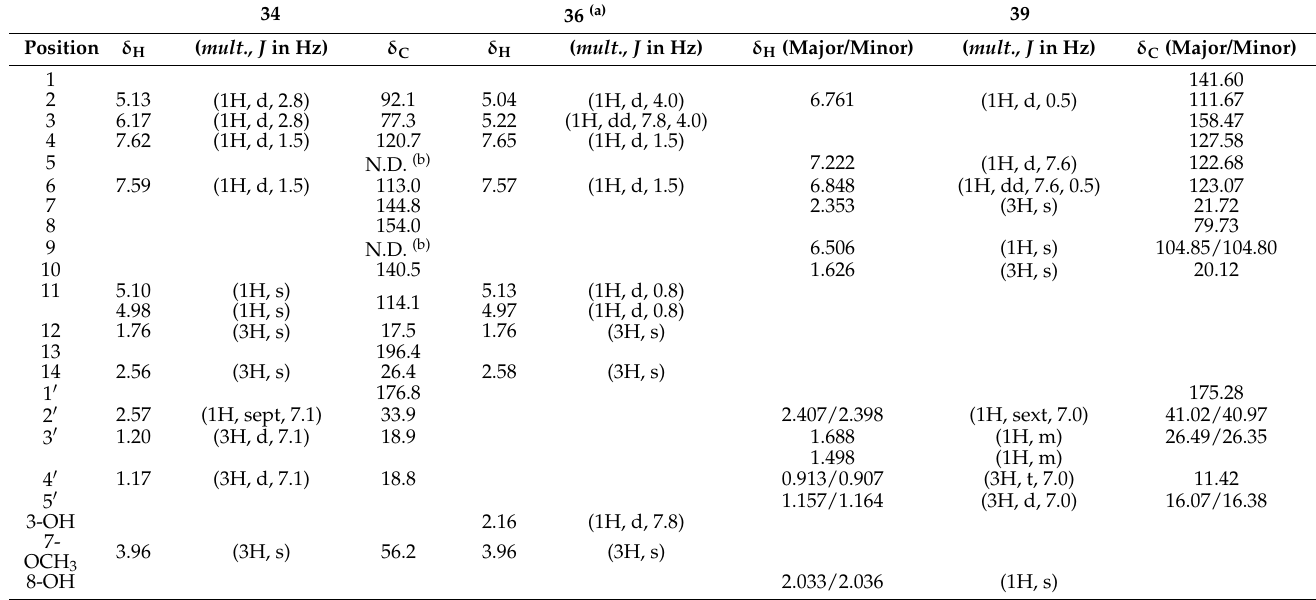
Table 5. 1 H (500 MHz) and 13 C (126 MHz) NMR data of 34 , 36 , and 39 in CDCl 3 . 34 36 (a)